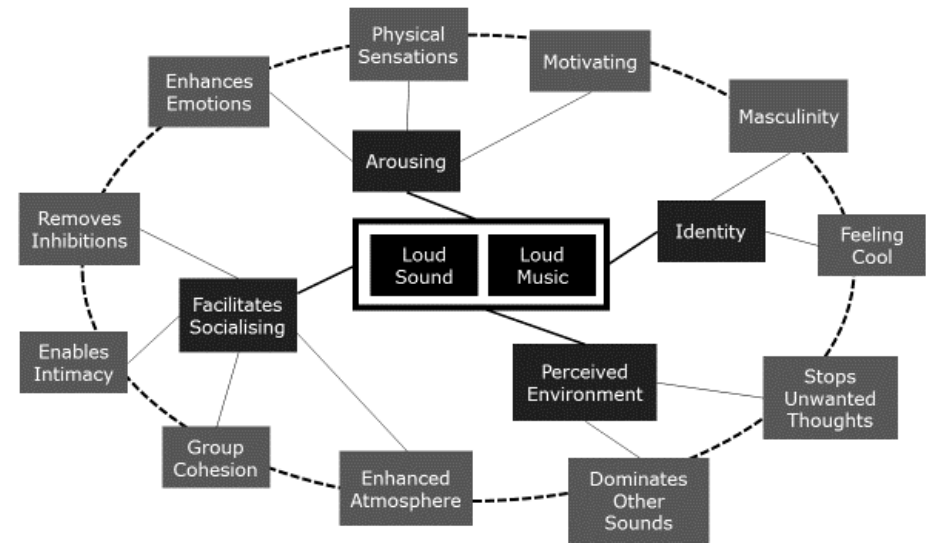
Figure 2. Mindmap of themes about the enjoyment of loud sound. In the people interviewed, loud sound was often loud music, and while other sources of loud sound were mentioned, most themes were associated with music. Four main themes were identified, and each contained sub-themes. In the diagram, the dotted ring represents the intuitive links between the sub-themes and demonstrates how they may support each other.